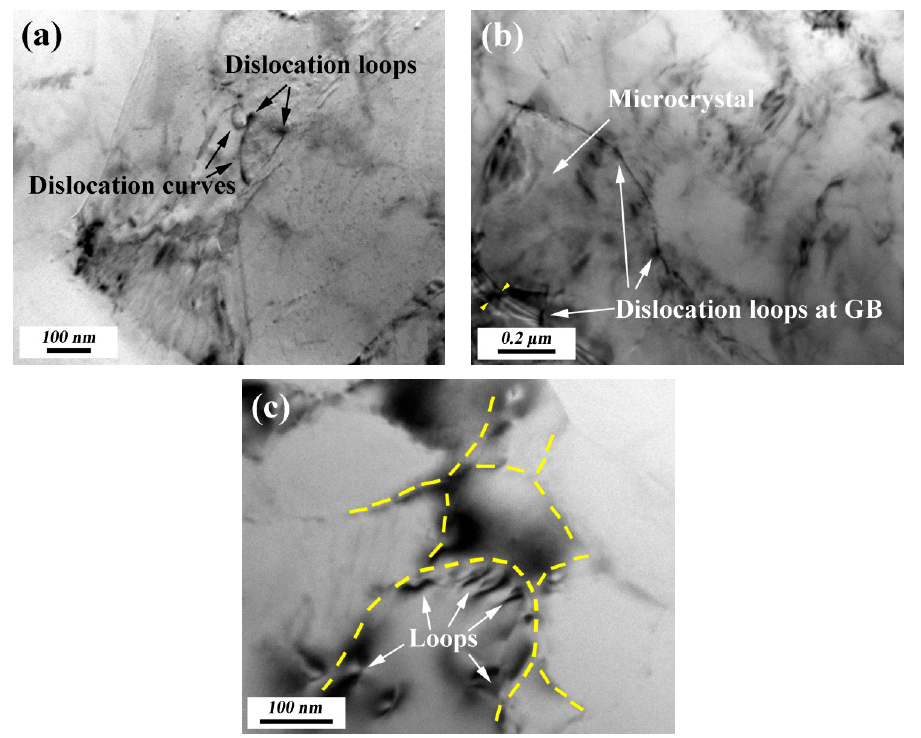
Figure 4. Interaction of dislocation with dislocation loop: ( a ) dislocations pinned with dislocation loops, 10 15 ions·cm − 2 ; ( b , c ) dislocation loops near GB, 10 16 ions·cm − 2 .